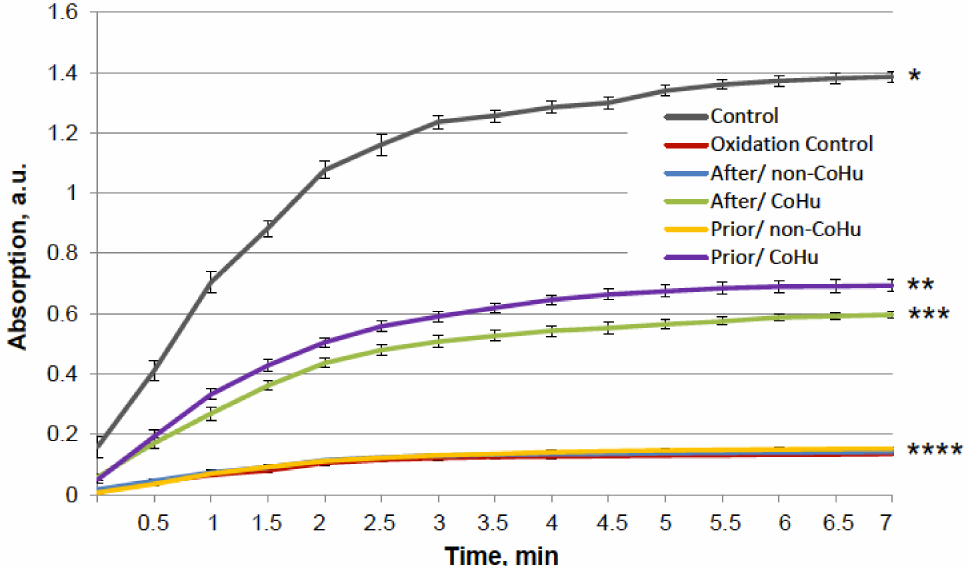
Figure 5. The effect of CoHu on oxidized HRP. Data presented as mean arbitrary units of 10 measure- ments ± SD. Prior/non-CoHu means that samples were treated with non-CoHu before inactivation. After/CoHu means that samples were treated with CoHu after inactivation. Prior/CoHu means that samples were treated with CoHu before inactivation. *, **, *** and ****—Lines with different superscripts differ significantly ( p <